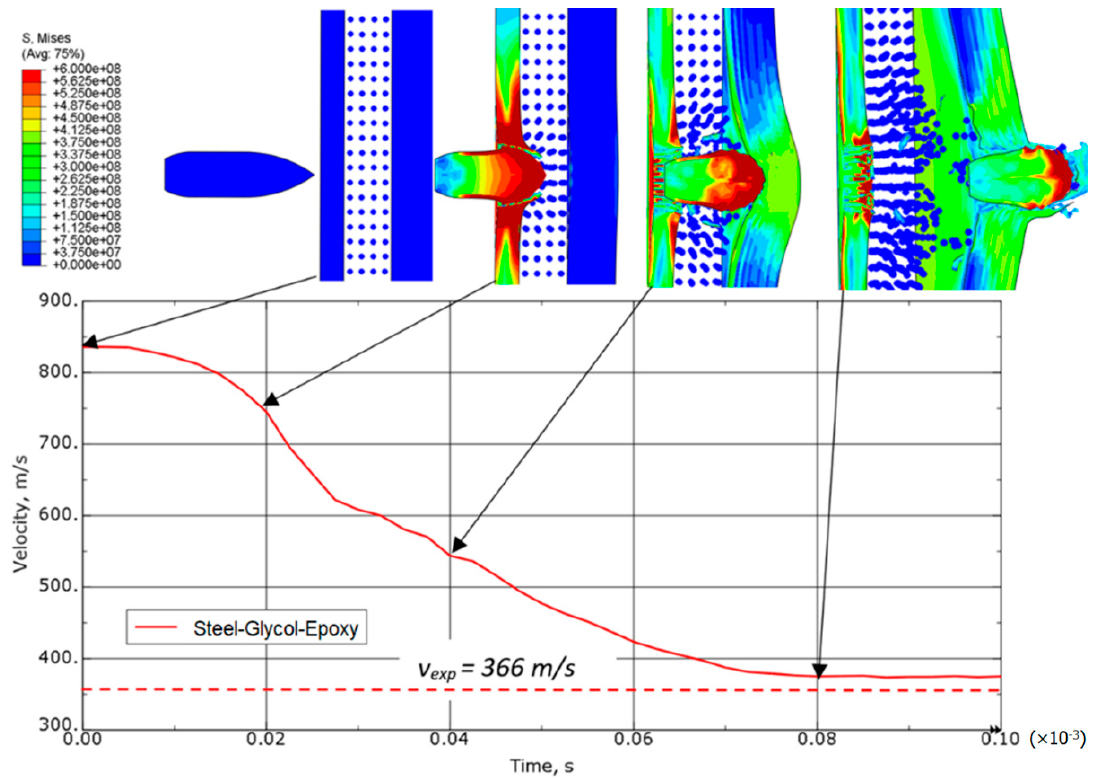
Figure 9. Equivalent von Mises stress distribution (in Pa) and speed drop for a steel ‐ glycol ‐ laminate variant.